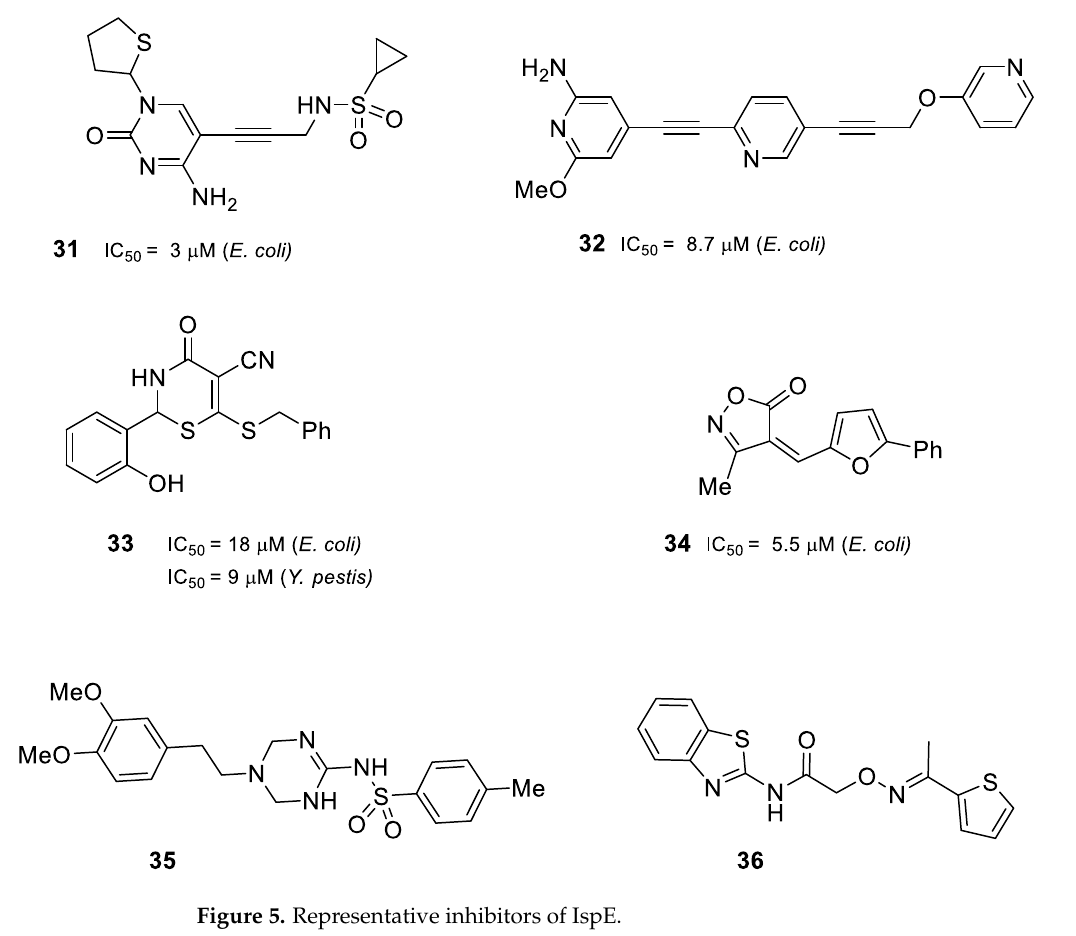
Figure 5. Representative inhibitors of IspE.